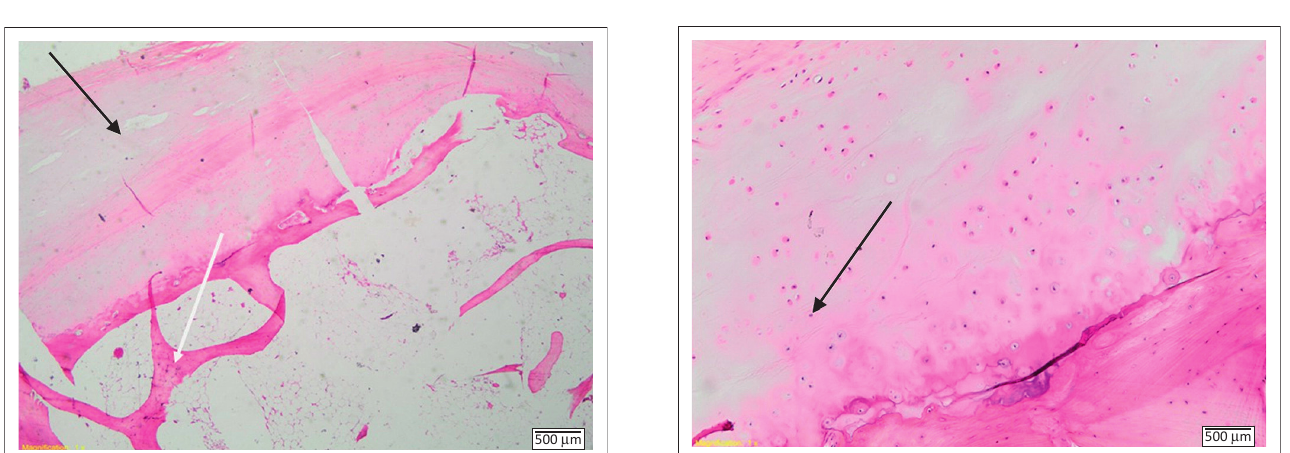
FIGURE 2: Coronal T1 (a) and protein density fat-saturation (b) MR images of the distal right femur demonstrate a large osteochondroma of the medial distal femur (blue arrow) accompanied by a thick overlying T1 iso-intense and PD fat-saturated hyperintense cartilaginous cap (10 mm in diameter) (red arrows) with bony (yellow arrow, image b), but not soft-tissue, infiltration visualised.